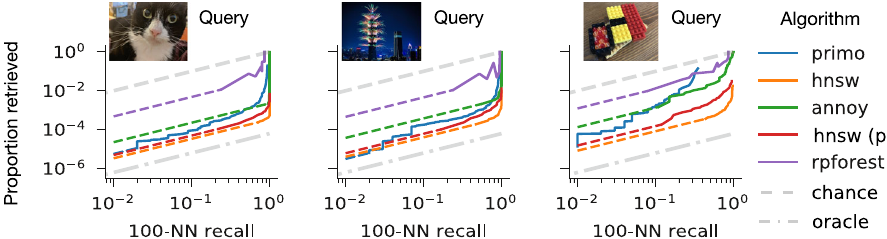
Fig. 4 Comparison of our technique ( “ primo ” , shown in blue) with state-of-the-art algorithms for in silico similarity search. Dashed gray and dashed- and-dotted gray lines represent chance performance and perfect performance, respectively. Not all of the algorithms could produce results towards the lower-left (low recall and low proportion retrieved). We assume these algorithms could be stopped early to produce fewer results with a linear decrease in recall; dashed continuations represent these linear